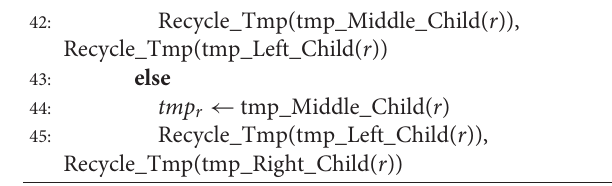
Algorithm 4 recursively creates such an optimal execution